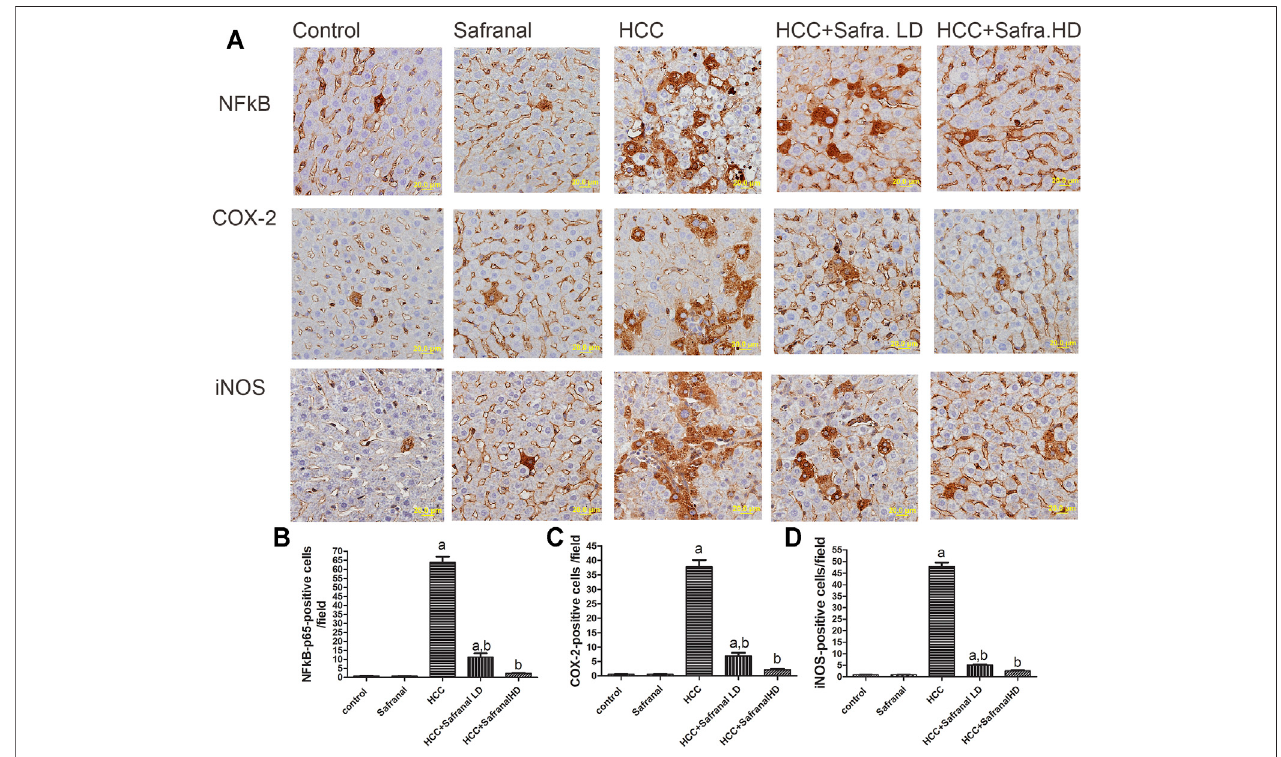
FIGURE 5 | Safranal inhibits DEN/2-AAF – induced upregulation of NF-kB-p65 and COX-2 and iNOS-positive cells expressions. (A) The upper panel are representative images of immunohistochemical staining with NF-kB-p65, COX-2, and iNOS in the liver section from all the groups (scale bar = 20 µm). (B, C, D) show quantitative analyses of NF-kB-p65, COX-2, and iNOS-positive cells. The positive expression of cells in each section was calculated by counting the number of brown staining in 10 fi elds at ×400 magni fi cations then the number of positive cells/ fi elds. Data are represented as mean ± SEM of six rats per group. Signi fi cance was determined by one-way ANOVA followed by Dunnett ’ s t -test: a p < 0.05 vs. control group, b p < 0.05 vs. HCC